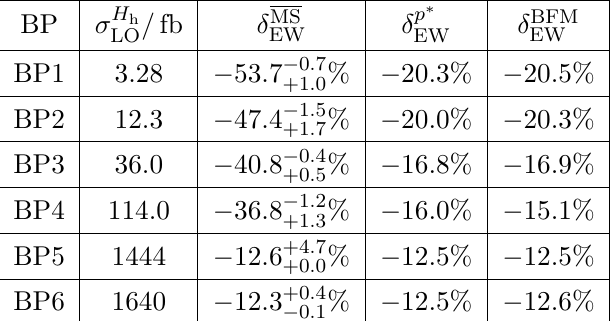
Table 12. Relative NLO corrections (cid:14) EW to heavy Higgs-boson H h production in Higgs strahlung pp H h (cid:22) (cid:0) (cid:22) + in the HSESM. The scale uncertainties in the MS scheme are estimated in- ! cluding the RG running of parameters as given by (6.7). For the BP1{4 the central scales are 580 GeV ; 480 GeV ; 380 GeV, and 280 GeV, respectively. For BP5 and BP6 the central scale is (cid:22) 0 = 2 M h = 250 : 18